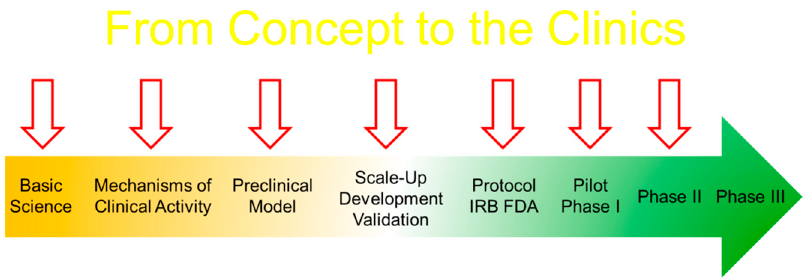
Figure 7. From Concept to the clinics: Workflow.